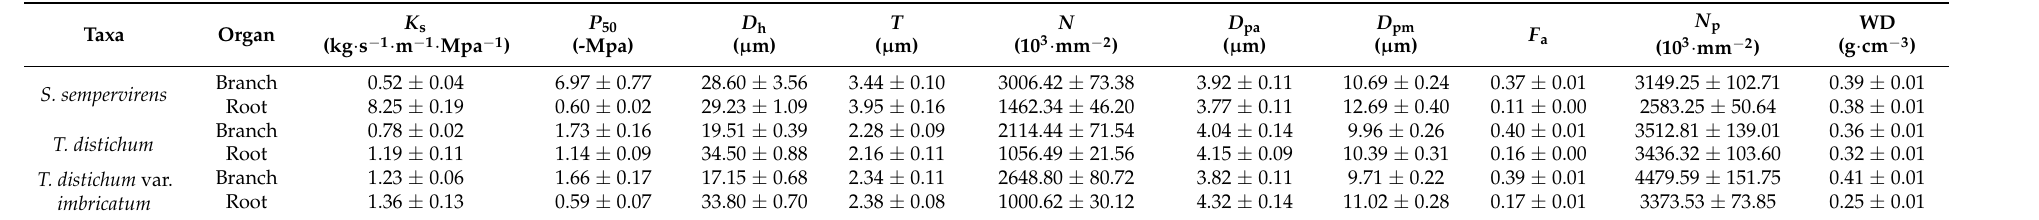
Table 2. Summary of xylem functional traits and anatomical structure of the target Cupressaceae